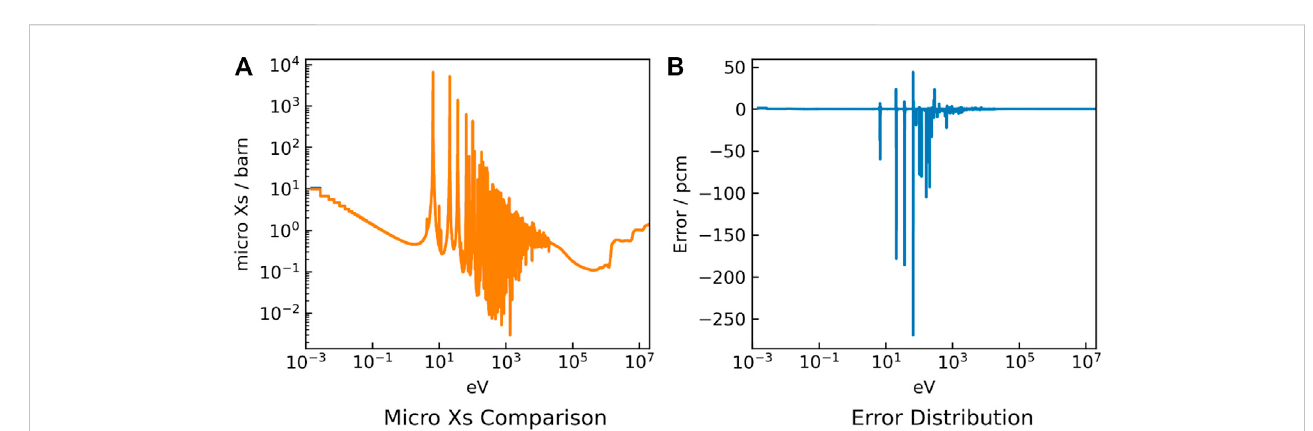
FIGURE 4 238 U absorption cross section results (A) and errors (B) for the MOX problem with thermal